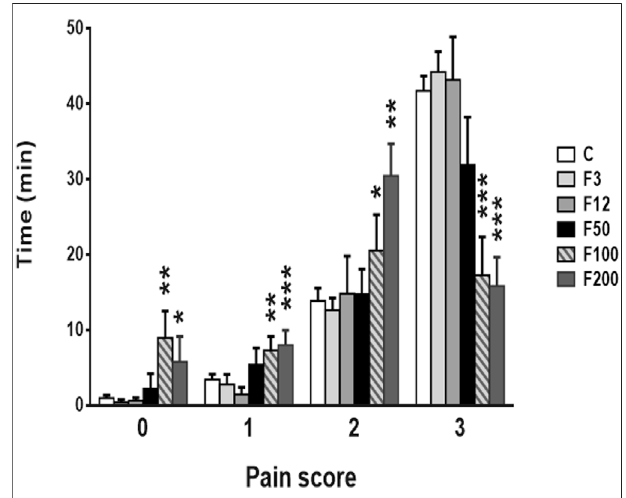
FIGURE 1 | Pain assessment with formalin test 3 weeks after birth in rat pups under long-lasting analgesia. The F100 and F200 groups showed reduced scores of the formalin-evoked behavioral pain. F3: Fentanyl ® (F) 3 μ g/kg/h ( n = 8), F12: 12 μ g/kg/h ( n = 10), F50: 50 μ g/kg/h ( n =